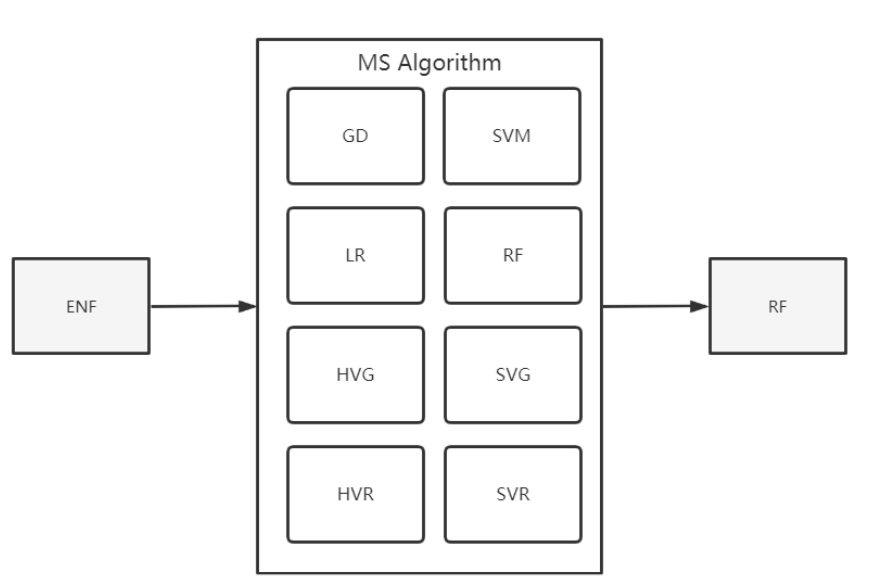
Figure 6. Basic principles of the model selection algorithm.